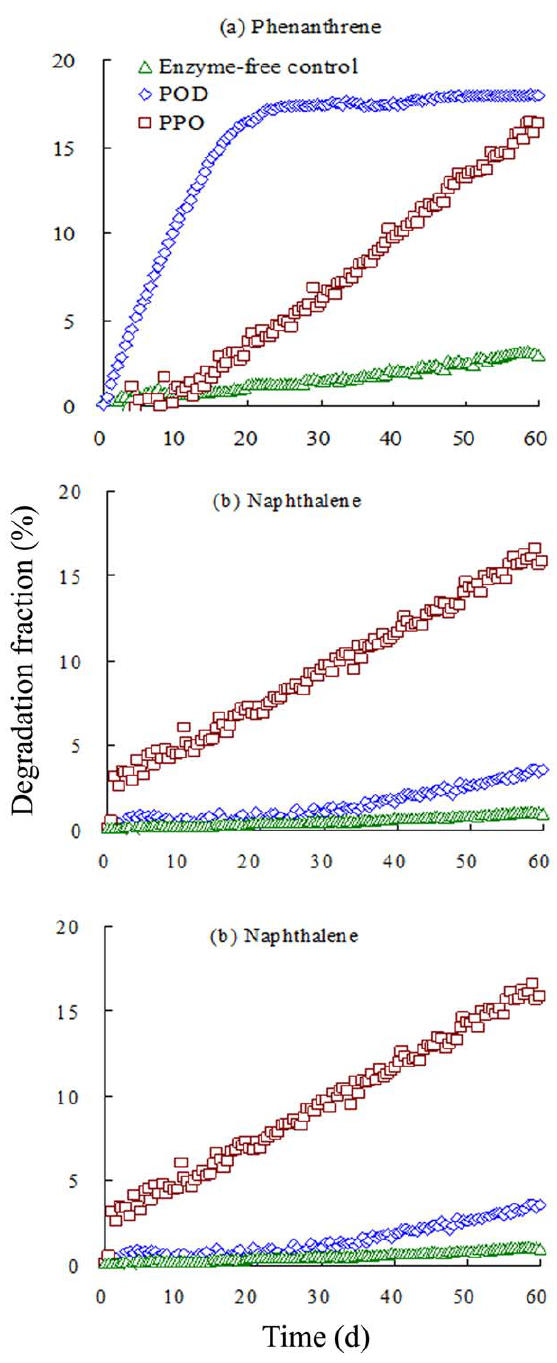
Figure 1. In vitro degradation fraction ( % ) of added ( a ) phenanthrene, ( b ) naphthalene, and ( c ) anthracene by POD and PPO over time. The degradation fraction (D PAH , %) of PAHs was estimated as: D PAH = (C PAH-o – C PAH-i )/C PAH-o 6 100%, where C PAH-i and C PAH-o represent the PAH concentrations in solution at time i and time 0,